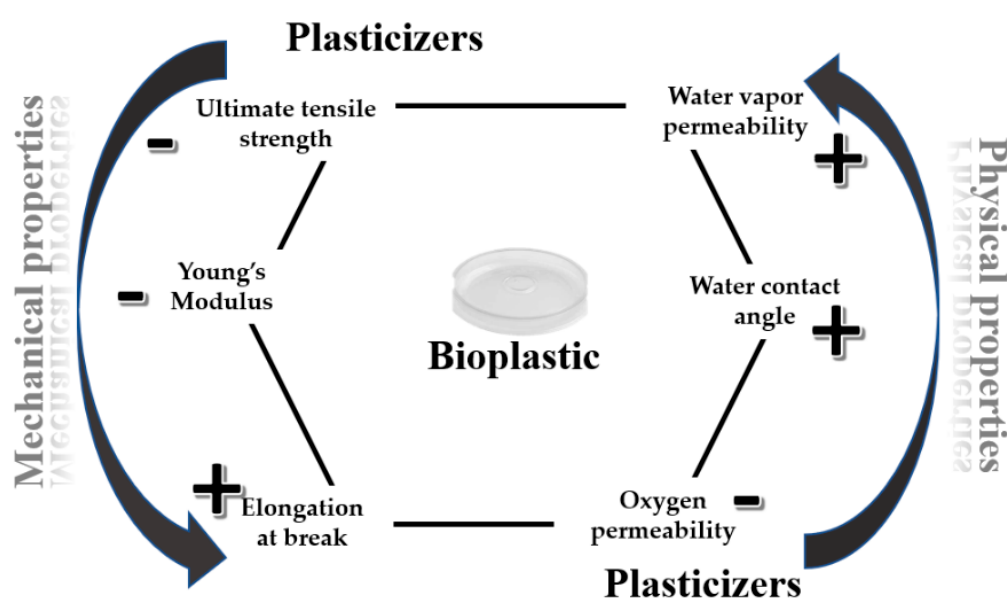
Figure 3. Effects of the plasticizers’ addition on mechanical and physical properties of bioplastic materials.